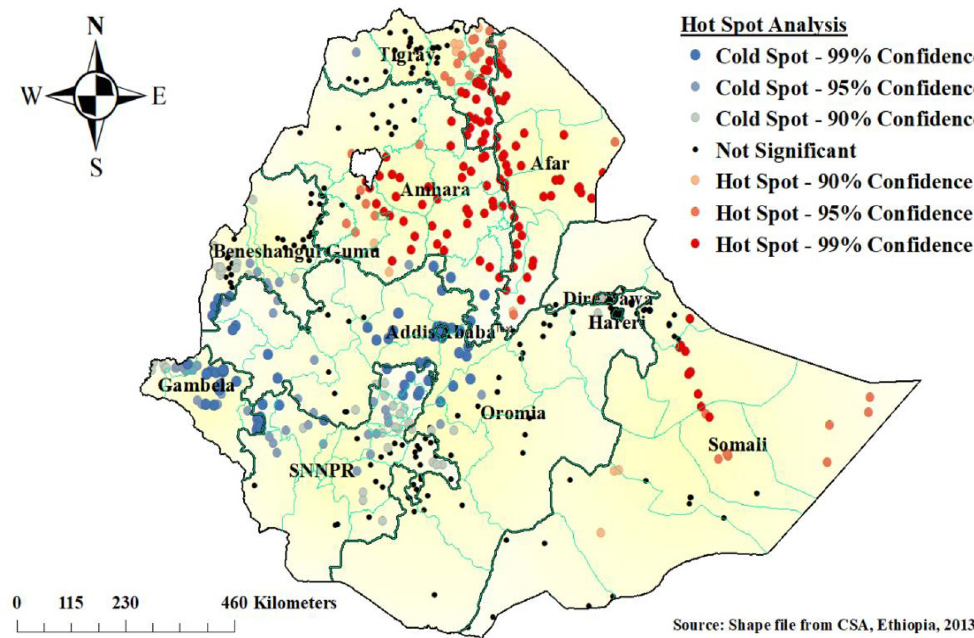
Fig 2. Hot spot analysis of poor consumption of foods rich in vitamin A among children aged 6–23 months, in Ethiopia. https://doi.org/10.1371/journal.pone.0252639.g002 regression (GWR) model were fitted. The bandwidth corrected Akakian Information Criteria (AICc), adjusted R 2 , and log-likelihood were considered for model comparison. Comparing